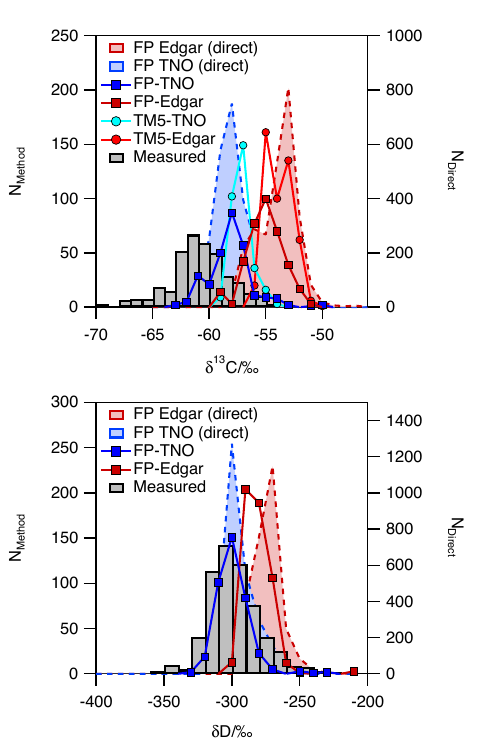
Figure 10. Histograms of CH 4 isotope source signatures at CE- SAR between October 2014 and March 2015. Bin widths are 1‰ for δ 13 C and 10‰ for δ D. Mean isotopic signatures are de- rived from measured data (grey bins), FLEXPART-COSMO mod- eling (squares) as well as TM5 modeling (circles) using the 12h MKP method. Two different inventories, TNO-MACC (blue) and Edgar/LPJ-WHyMe (red), were used. The shaded areas show his- tograms for the “direct” source signatures that were picked up along the FLEXPART-COSMO trajectory (right axis). Means and stan- dard deviations of these distributions are shown in Table